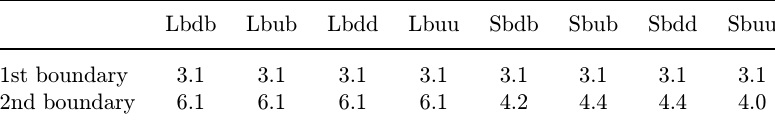
solid lines indicate the positions of boundaries are 3.1 mm, 4 mm, 5.1 mm, 6.2 mm, 7.4 mm and 8.7 mm. Compared with the actual boundaries, the errors are 0.1 mm, which is equal to one puncture step.